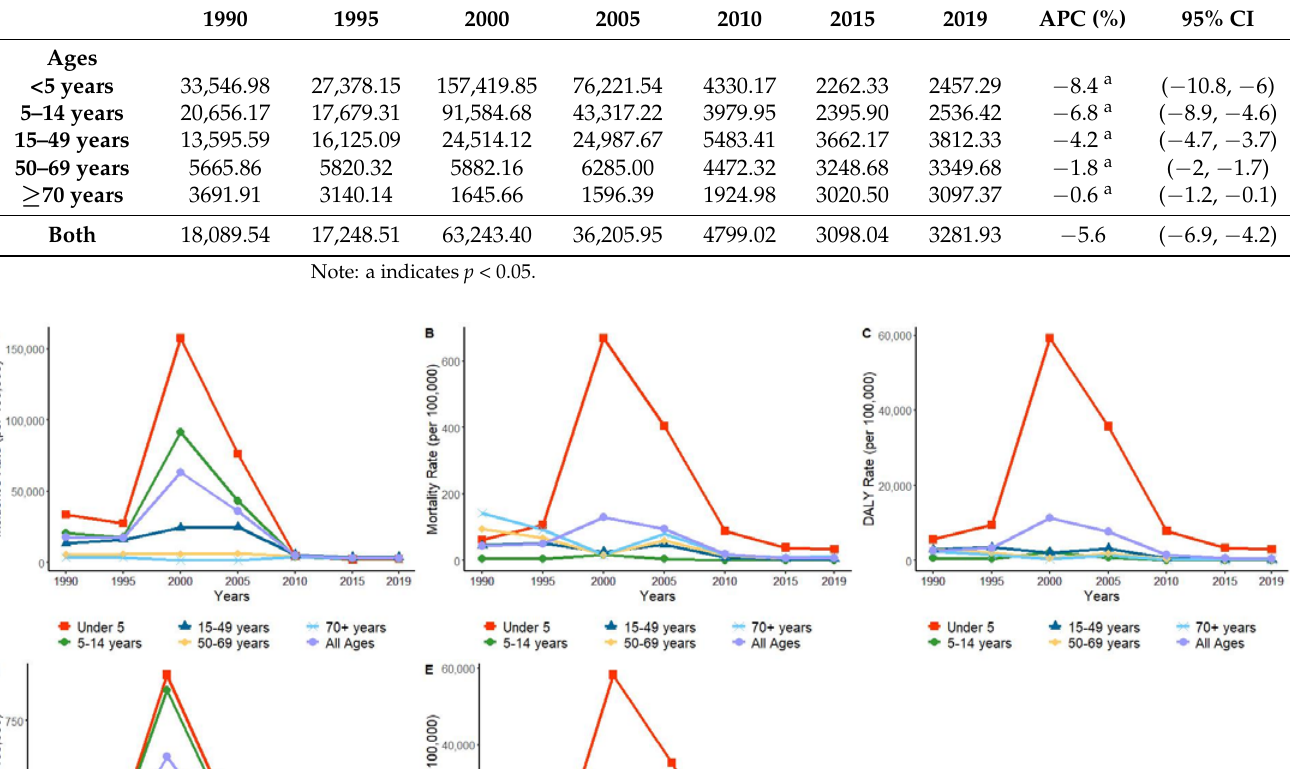
Table 2. Changes in incidence of malaria per 100,000 population by age group in STP, 1990–2019.